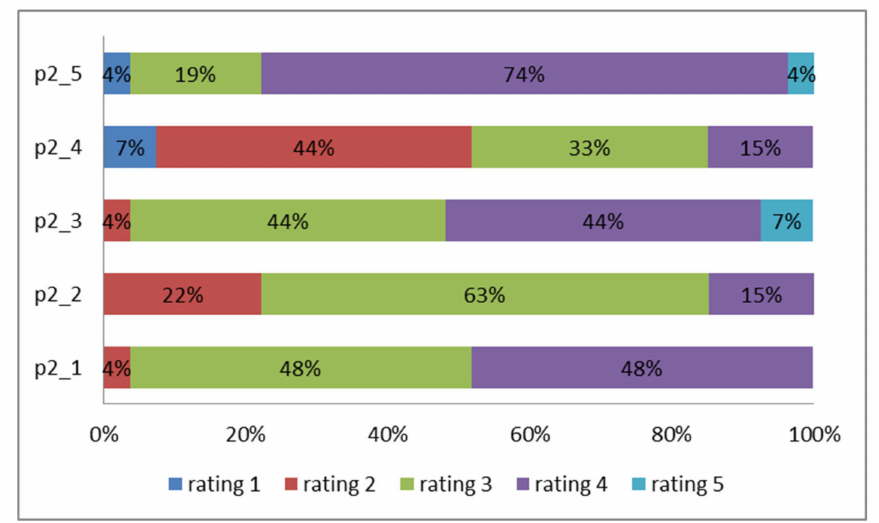
Figure 3. Assessment of the risks / challenges associated with implementing CE in the coal power